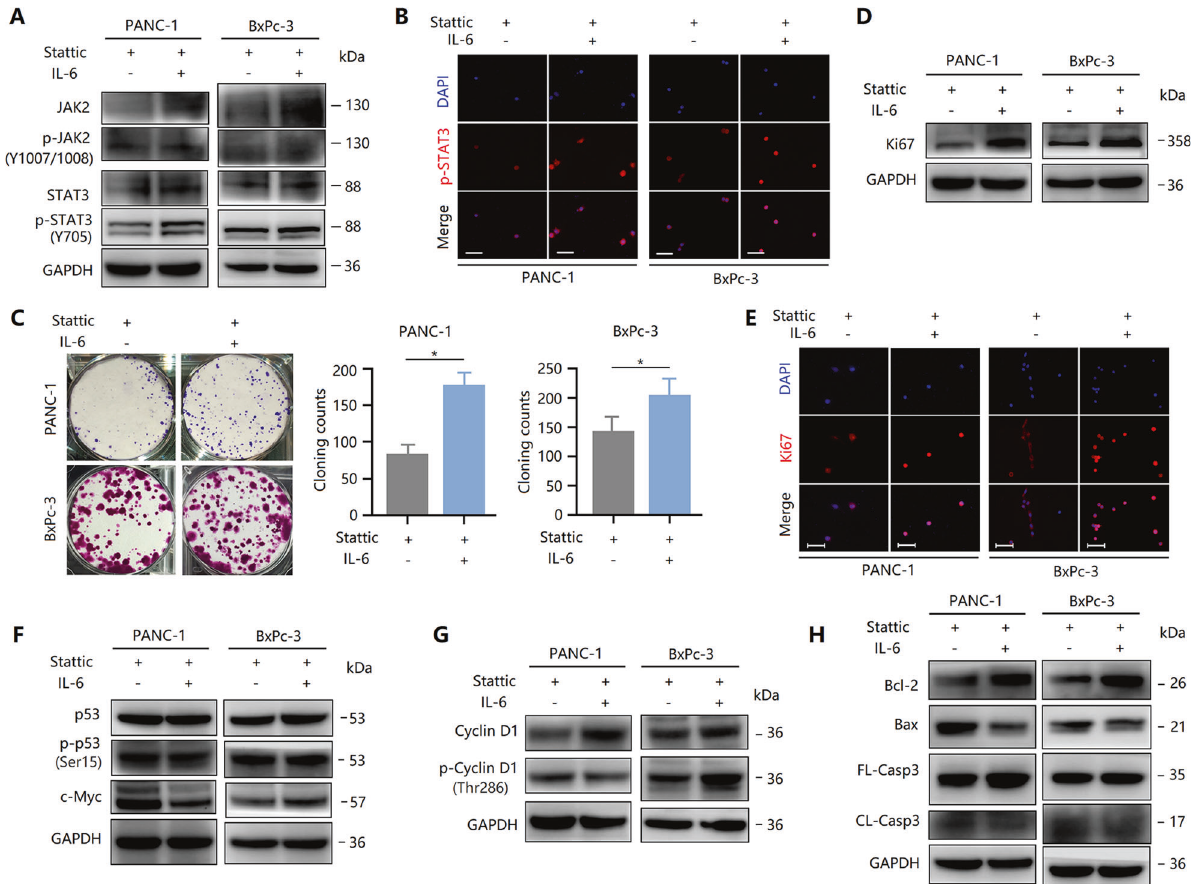
Fig. 7 IL-6 partially abolishes the inhibitory effect of Stattic in PCCs via STAT3. PCCs were treated with 10 μ M of Stattic with or without IL-6 for 24 h. A Expression and phosphorylation of STAT3 and JAK2 in the indicated groups. B Immunocytochemical staining of p-STAT3 in Stattic- treated PANC-1 and BxPc-3 cells with or without IL-6. Bar = 50 μ m. C Colony formation assay revealing the proliferation of Stattic-treated PANC-1 and BxPc-3 cells with or without IL-6. D Expression of Ki67 in Stattic-treated cells with or without IL-6. E Immunocytochemical staining of Ki67 in Stattic-treated PANC-1 and BxPc-3 cells with or without IL-6. Bar = 50 μ m. F Expression of c-Myc and p53 activity in cells treated with or without IL-6. G Expression and phosphorylation of cyclin D1 in Stattic-treated PANC-1 and BxPc-3 cells with or without IL-6. H Western blot analysis showing the expression of Bcl-2, Bax, FL-Casp3, and CL-Casp3 in Stattic-treated PANC-1 and BxPc-3 cells with or without IL-6. * P <